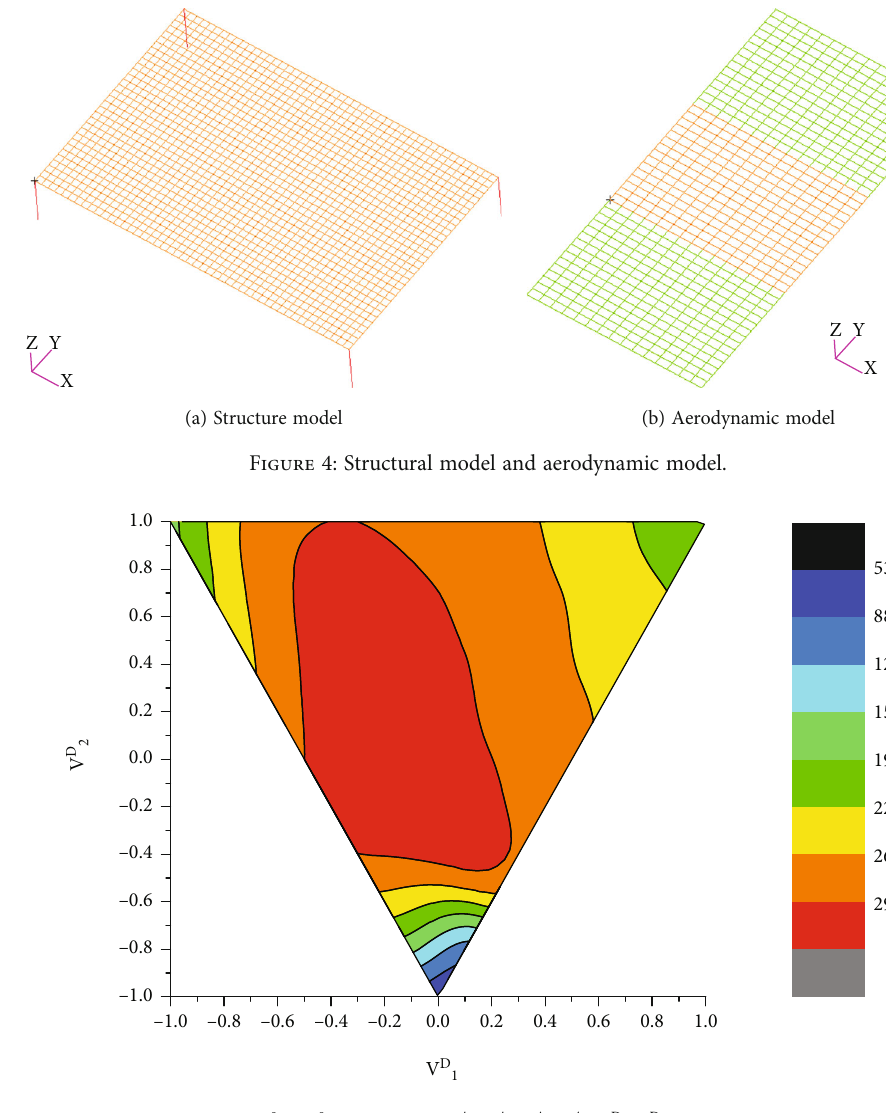
(cid:2) = ½ 0, 0, 0, 0, 0, 0 (cid:2) , V A , V A , V A , V D , V D 1 2 3 4 3 4